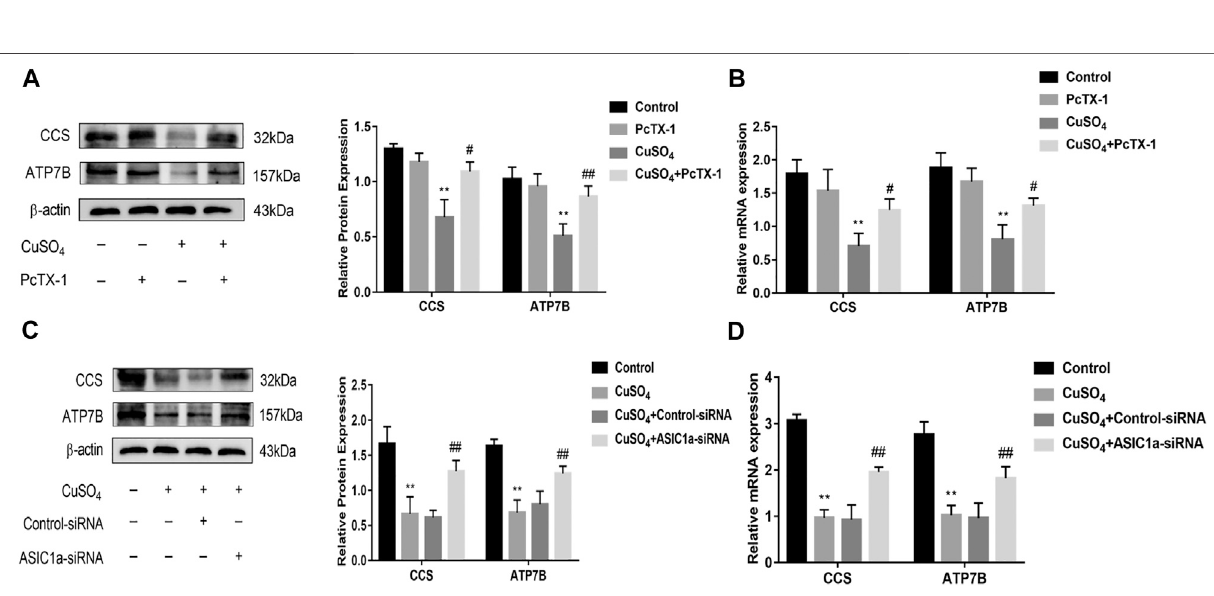
FIGURE 4 | Effects of inhibition and silencing of ASIC1a on copper metabolism-related proteins (A) Western blotting analysis and densitometric quanti fi cation of ATP7B,andCCSproteinlevelsinHSCstreatedwithPcTX-1; (B) mRNAlevelsofATP7B,andCCSinHSCstreatedwithPcTX-1 (C) EffectofASIC1a-siRNAtransfection on the expression of copper metabolism-related proteins ATP7B and CCS; (D) mRNA levels of ATP7B and CCS in HSCs after transfection with ASIC1a-siRNA. Statistical analyses were performed using t-test. Data are expressed as the mean ± SEM ( n (cid:2) 4). * p < 0.05, ** p < 0.01 vs. Control group; # p < 0.05, ## p < 0.01 vs. CuSO 4